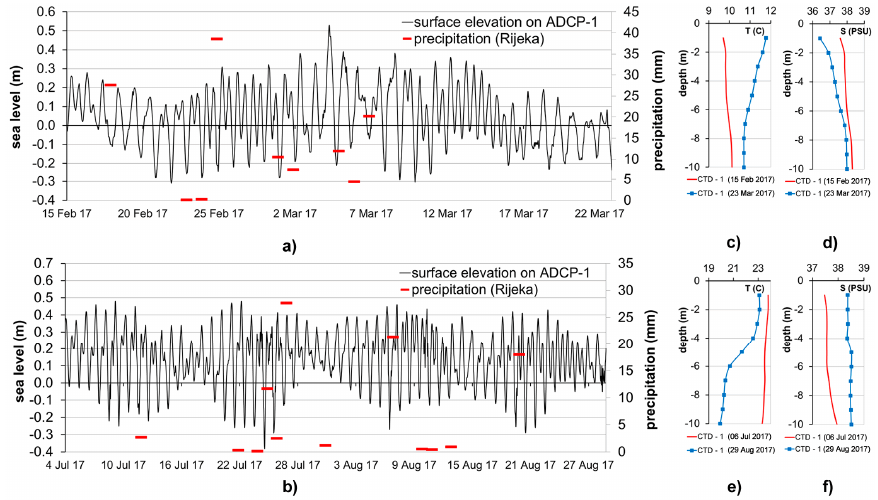
Figure 4. Time series of surface elevations recorded at the ADCP station 1 and daily precipitation at the meteorological station Rijeka ( ϕ = 45020 ′ , λ = 14027 ′ ) for the ( a ) winter and ( b ) summer measurement periods; the sea temperature ( T ) and salinity ( S ) throughout the vertical sea column at site 1 for ( c , d ) the winter and ( e , f ) summer measurement periods.